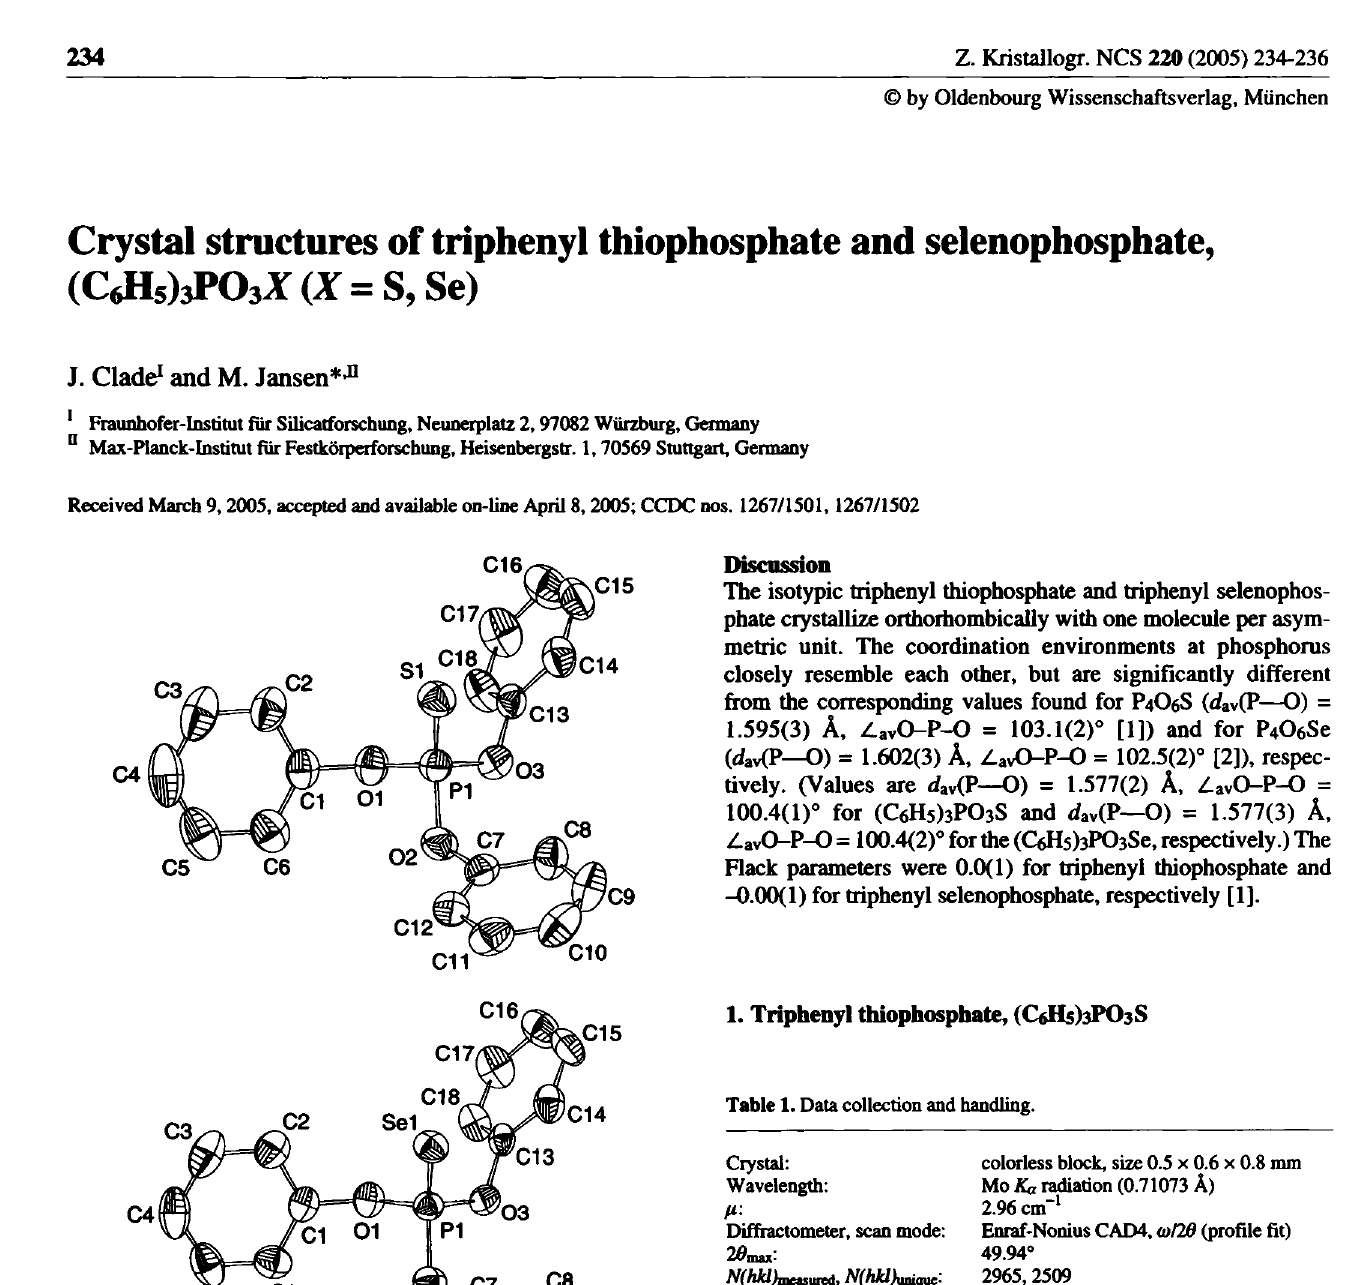
Table 1. Data collection and handling.